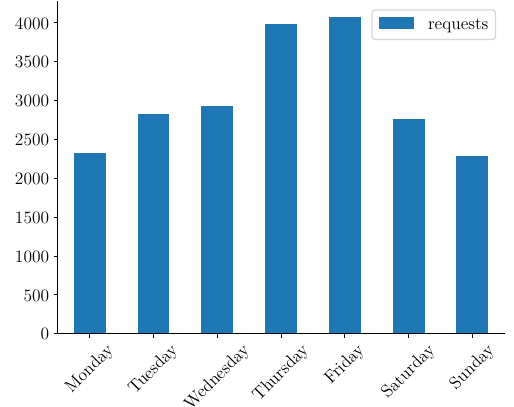
Figure 3. Daily request throughout the